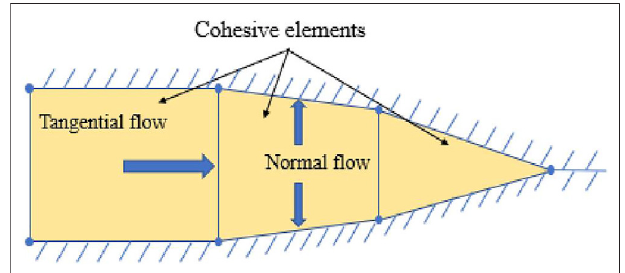
FIGURE2| Fracturing fl uid fl owpatternwithinthecohesiveelement.The fl uid fl ow continuity equation in the fracture is (Zhilong et al.,